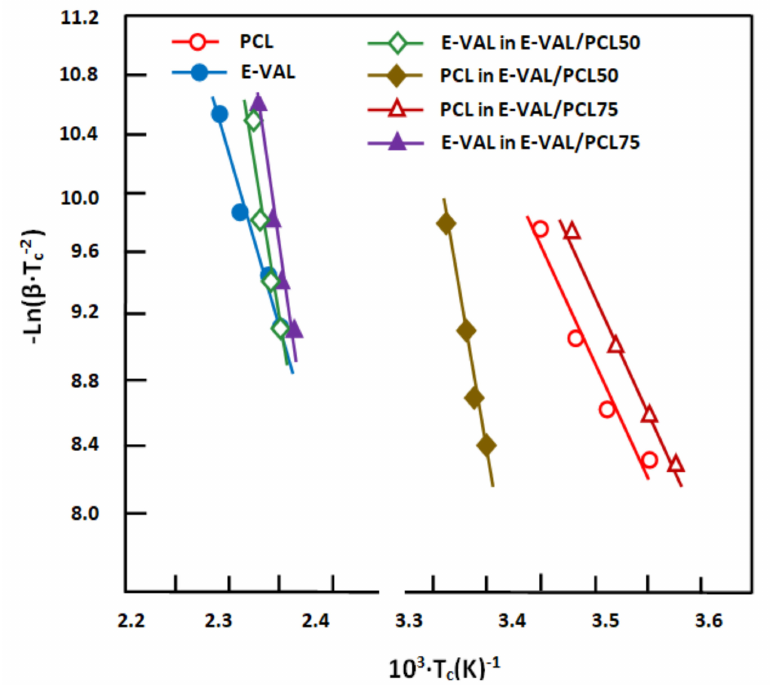
Figure 13. Variation of ln( β /T 2 ) vs. the inverse of the temperature of pure E-VAL and E-VAL/PCL containing 75 and 10 wt%